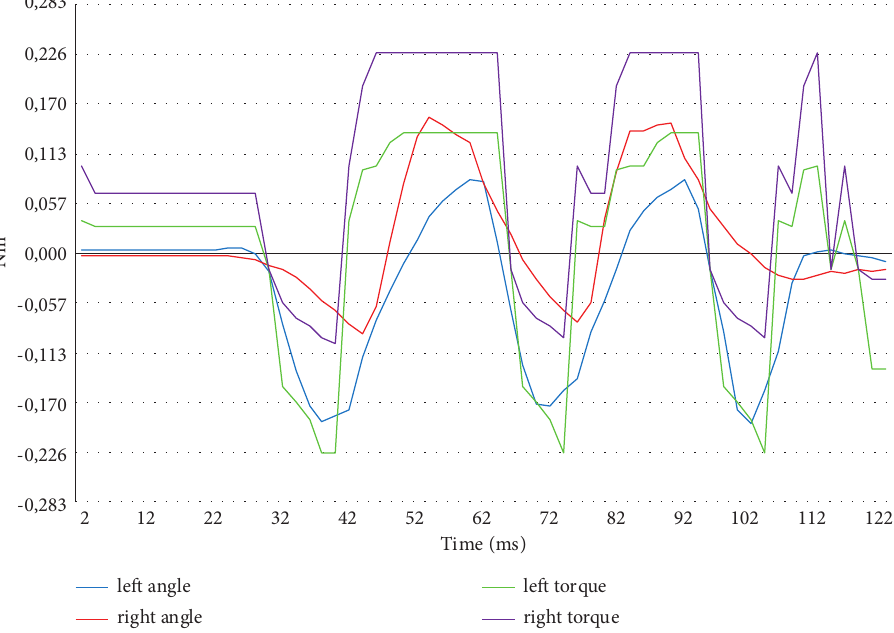
Figure 10: Assistive torque generated for a normal walking process.